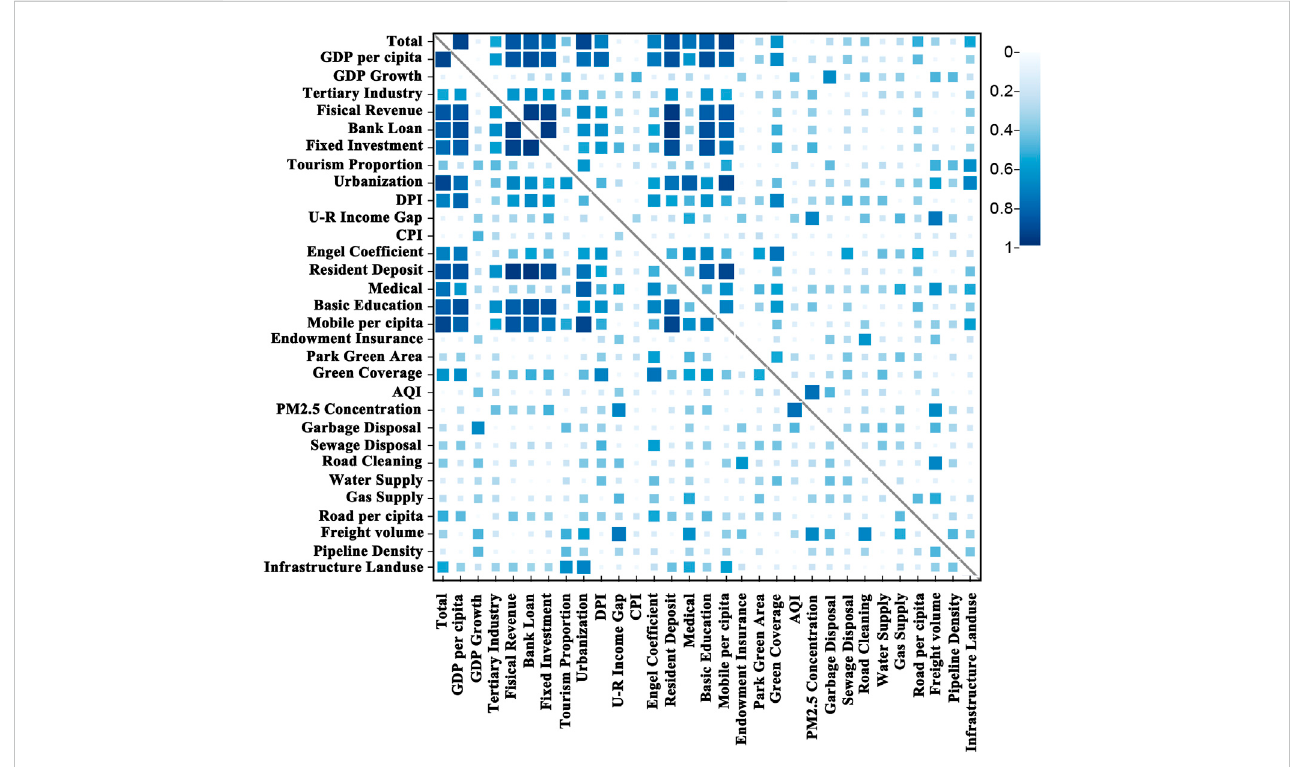
FIGURE 8 Pearson correlation coef fi cient for each